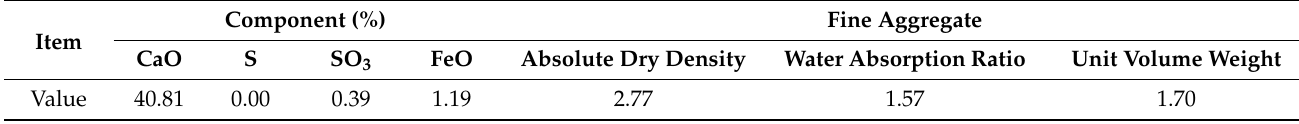
Table 10. Properties of the air-cooled slag fine aggregate.